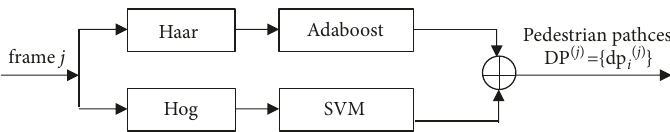
Figure 2: Classifier combination for pedestrian